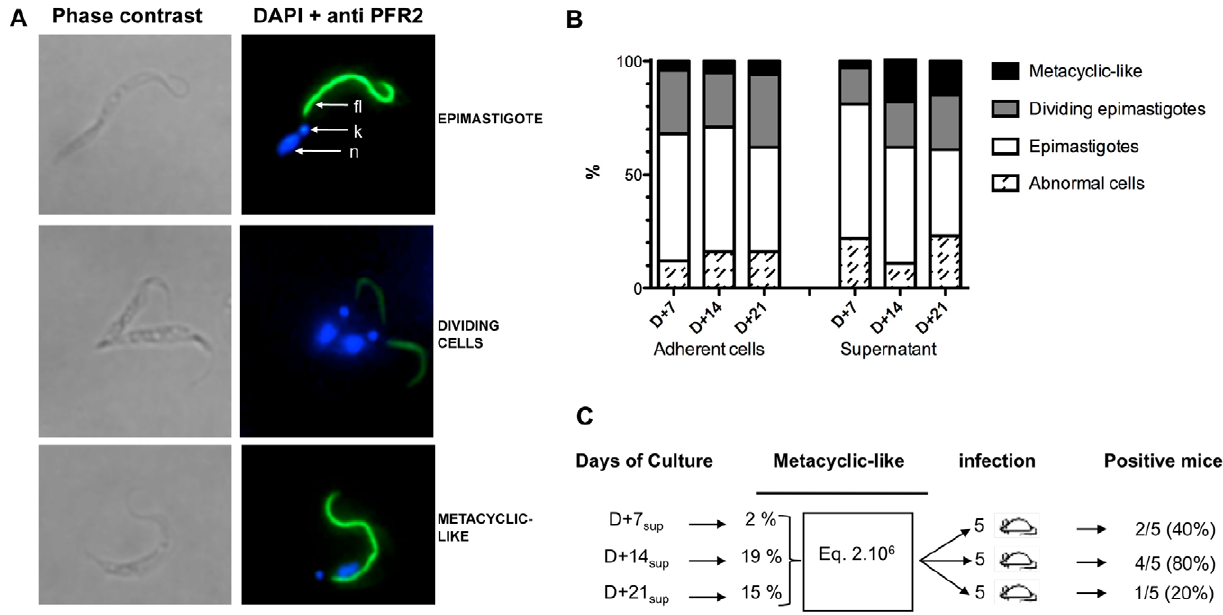
Figure 3. Characterization of T.vivax developmental stages invitro . Supernatant and adherent layer parasites taken from ongoing axenic cultures were labeled with anti-PFR2 antibodies (see Methods), stained with DAPI and examined under an epifluorescence microscope: n=nucleus; k=kinetoplast; fl=flagellum (A). Bars represent relative numbers in each parasite population (B). Metacyclic-like parasites in culture supernatants were quantified by IMF on days 7, 14 and 21. An equivalent number of metacyclic-like trypomastigotes (2 6 10 6 ) were taken at each time point and injected intraperitoneally in groups of 5 Balb/c male mice. Parasitemia was measured individually for 28 days and the number of positive mice (and % within the group) was